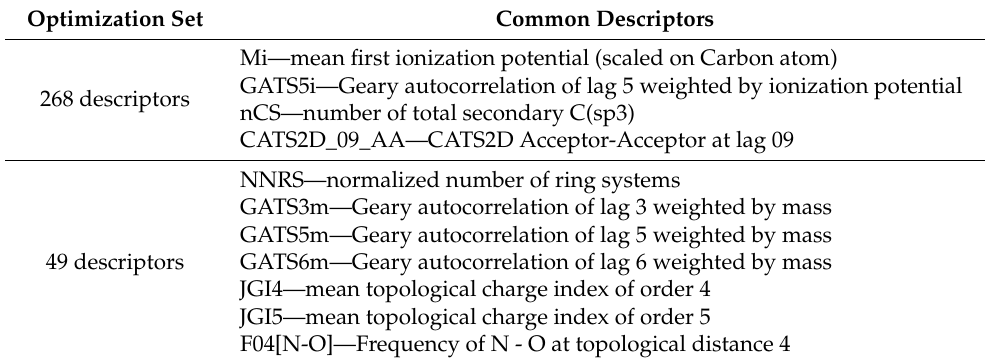
Table 3. List of common descriptors.